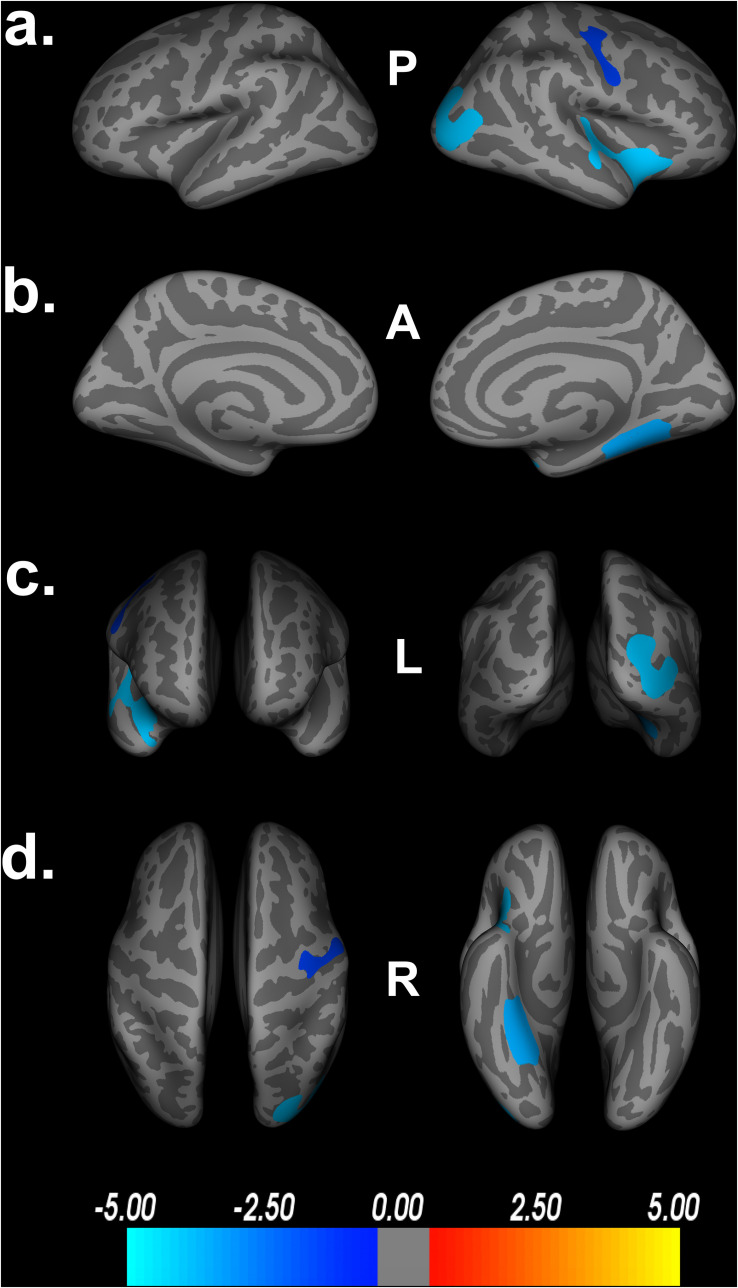
Decreased cortical thickness related to POSIT Double Decision scores using Monte Carlo simulations, set at 10,000 iterations and a cluster-wise threshold p = 0.05. (a) left and right hemisphere lateral views, respectively. (b) left and right hemisphere medial views, respectively. (c) anterior and posterior views, respectively. (d) superior and inferior views, respectively. P- posterior, A- anterior, L- left, R- right.